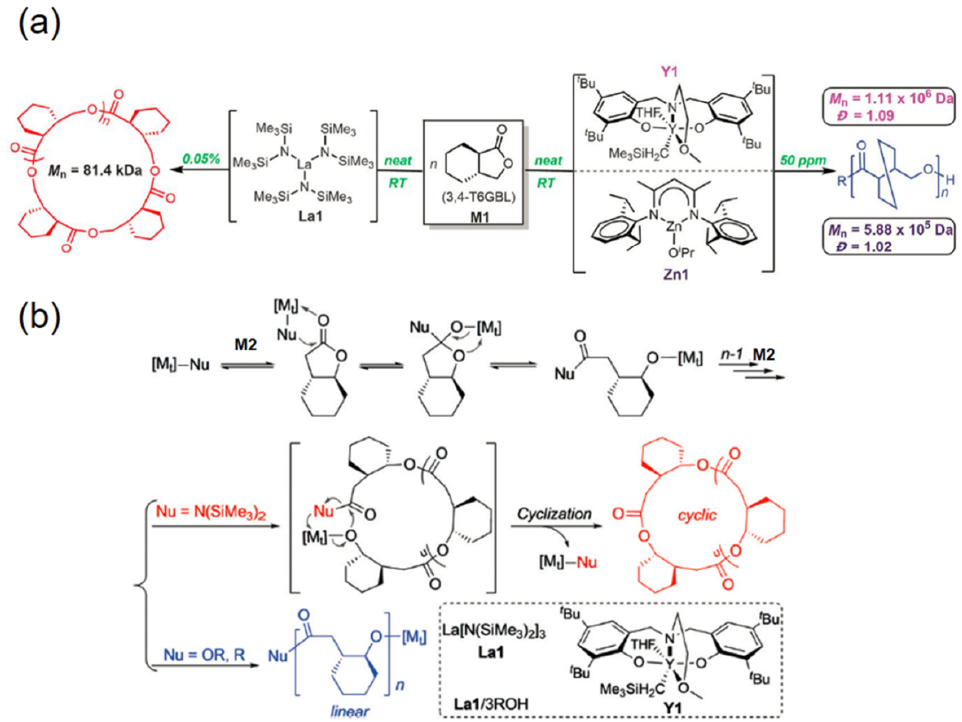
Figure 5. Reversible polymerization in ring-opening polymerization systems. ( a ) Metal catalyzed ROP of 3,4-T6GBL (M1) to linear and cyclic polymers; ( b ) Proposed pathways for metal catalyzed ROP of 4,5-T6GBL (M2) to linear and cyclic polymers. Reproduced with permission from